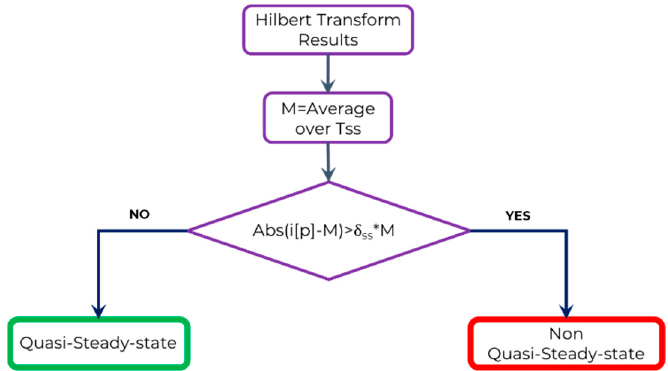
Figure 2. Quasi-Steady-State Identification (QSSI) algorithm used for the hybrid HH